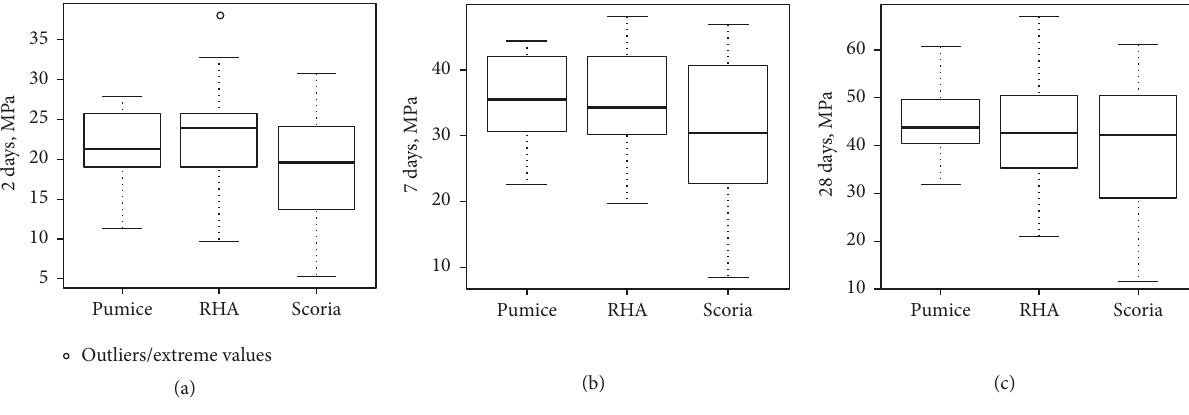
Figure 9: Effect of materials on compressive strength of blended